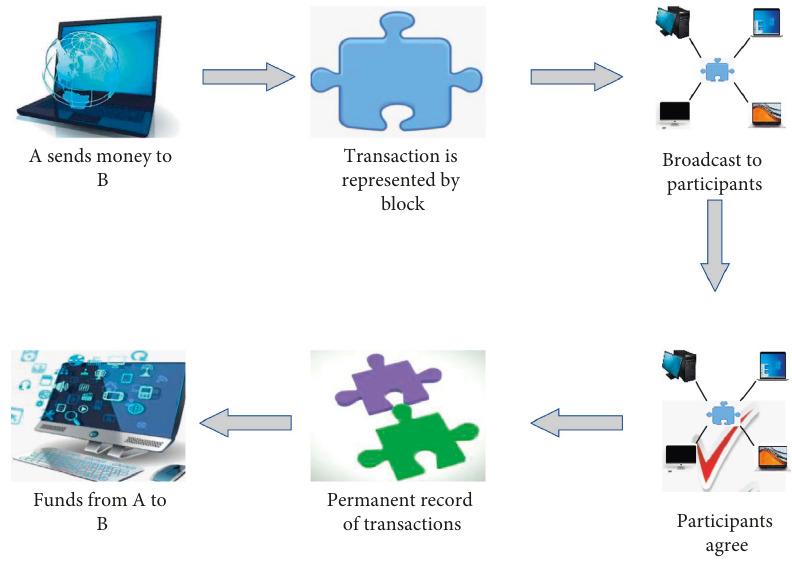
Figure 1: The working principle of blockchain.